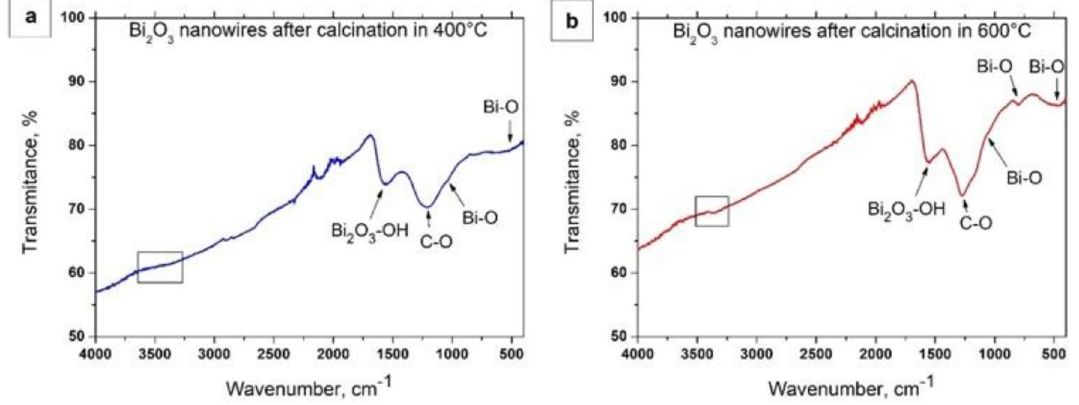
Figure 3. FTIR spectra recorded for the obtained one-dimensional bismuth oxide nanostructures produced by calcination of fibrous composite PAN/Bi 2 O 3 mats at 400 °C ( a ) and 600 °C ( b (Fig. 2b) and 200 nm for the diameter and 2.125 μm long (Fig. 2c, d). Considering the thickness to length ratio of obtained one-dimensional nanostructures, allows to classify them as ceramic nanowires. Studies of the structure of produced Bi 2 O 3 nanowires carried out with, as well as with the use of the HAADF detector, and results of diffraction studies obtained with the use of analytical microscopy in nano areas in the STEM mode, allowed to determine the phase composition and amorphous structure of the studied nanostruc- tures (Fig. 2c–f). The TEM images (Fig. 2c, d) showed a uniform contrast in the whole area of the studied bismuth oxide nanostructures, which proves the absence of crystallites in their structure. Moreover, further analysis of the obtained TEM images showed that the presented Bi 2 O 3 structures consisted of many fine, amorphous grains of various sizes and shapes (Fig. 2b–d). The electron diffraction spectrum obtained for a single Bi 2 O 3 nanowire produced at 600 °C, in the form of fuzzy rings formed as a result of electron beam scattering, indicates their amorphous character (Fig. 2f). The TEM examinations of the morphology and structures of the obtained one-dimensional bismuth(III) oxide ceramic nanostructures permitted to define the influence of the applied calcination temperatures on the structure, morphology, optical and electrical properties of the produced one- dimensional bismuth oxide nanostructures. FTIR analysis. In order to analyse the oscillatory transitions of atoms vibrating between the oscillatory levels in the molecules of the produced bismuth oxide nanowires and to determine the functional groups existing therein, the transmittance FTIR spectra were analysed as a function of the wavenumber in the range from 400 to 4000 cm -1 . A wide band visible in the wavenumber range equalling to 3500 cm -1 (marked with rectangles— Fig. 3), visible both in the case of Bi 2 O 3 one-dimensional nanostructures obtained by calcination of hybrid PAN/ Bi (NO